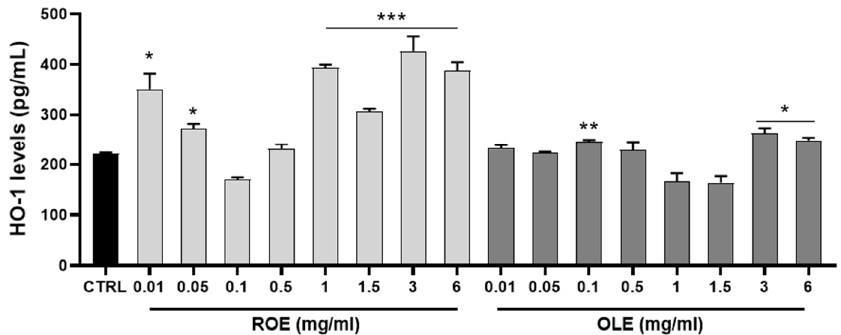
Figure 2. Measurement of HO-1 levels after 24 h of treatment with ROE and OLE at different concentrations. Results are expressed as mean ± SEM. Significant vs CTRL: * p < 0.05; ** p < 0.005; *** p < 0.0005.